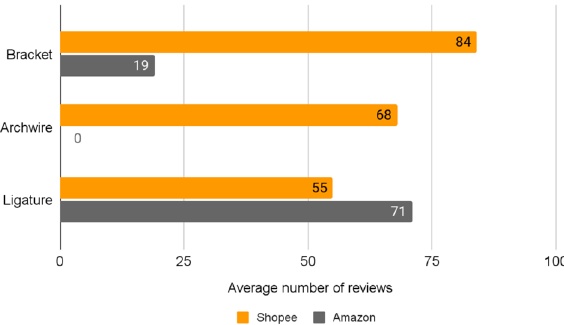
Figure 2. Average number of orthodontic component reviews on Amazon and Shopee.